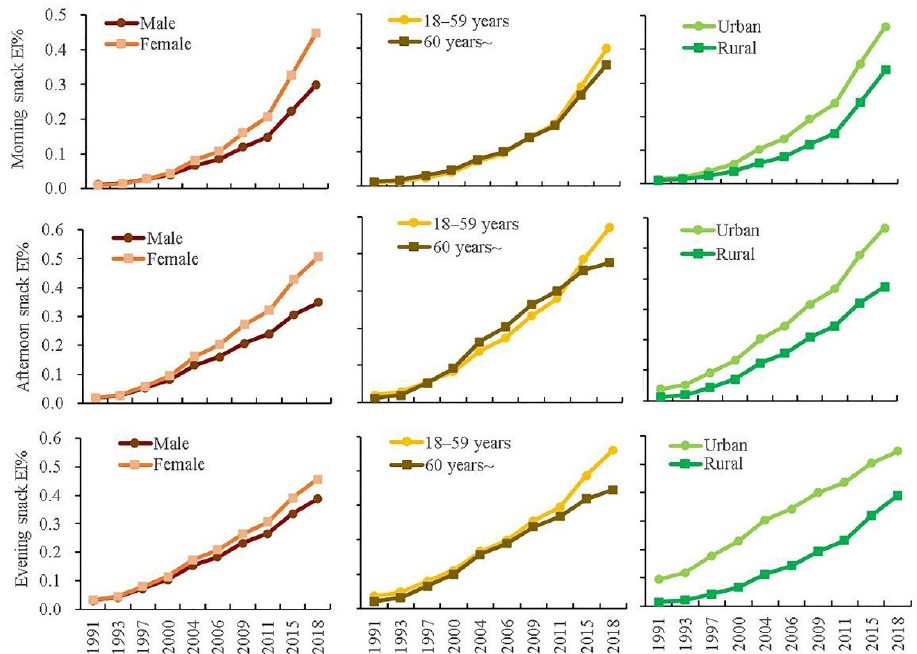
Figure 3. Marginal means of energy proportion of morning snack, afternoon snack, evening snack by gender, age ‐ group and location 1 . 1 Log ‐ transformation was done to improve normality. Marginal mean was calculated from multilevel Tobit regression model. Models were adjusted for age, gender, educational level, geographical region, total physical activity, smoking, alcohol drinking, annual per capita household income, community urbanicity index, chronic disease history, total energy intake, and